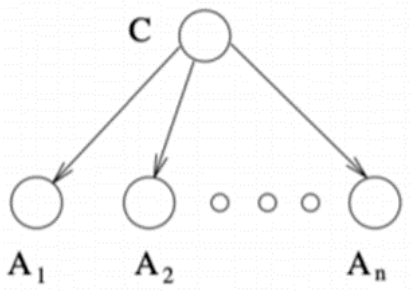
Figure 3. Naïve Bayes network structure.